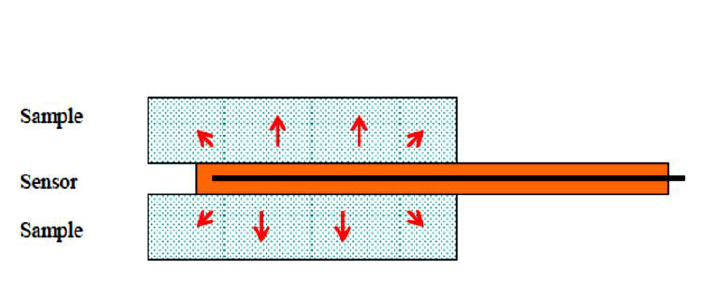
Fig. 3(a): Hot Disk sensor.